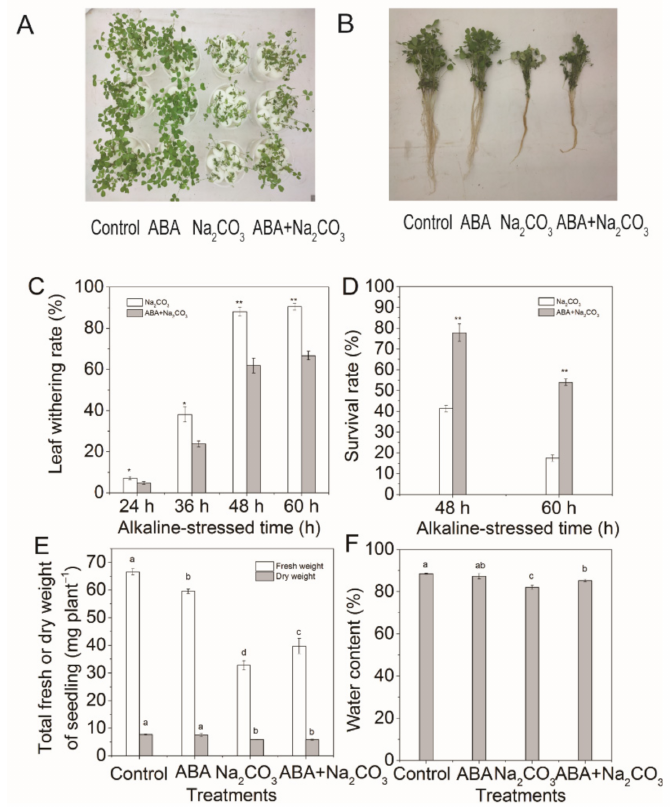
Figure 1. Abscisic acid (ABA) priming protected alfalfa ( Medicago sativa L.) seedlings from wilting and death under alkaline conditions. Eighteen-day-old alfalfa seedlings were root-drenched